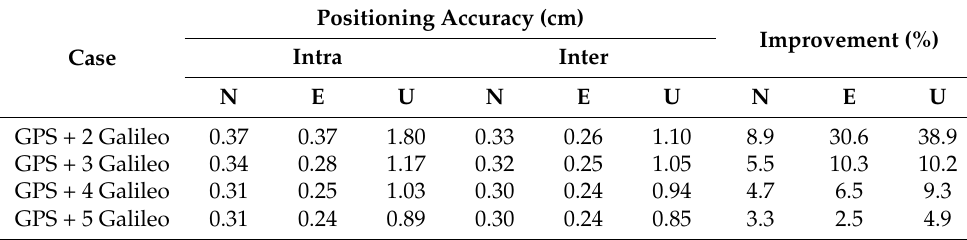
Table 5. Positioning comparison for the intra-system model and the inter-system model with differ- ent